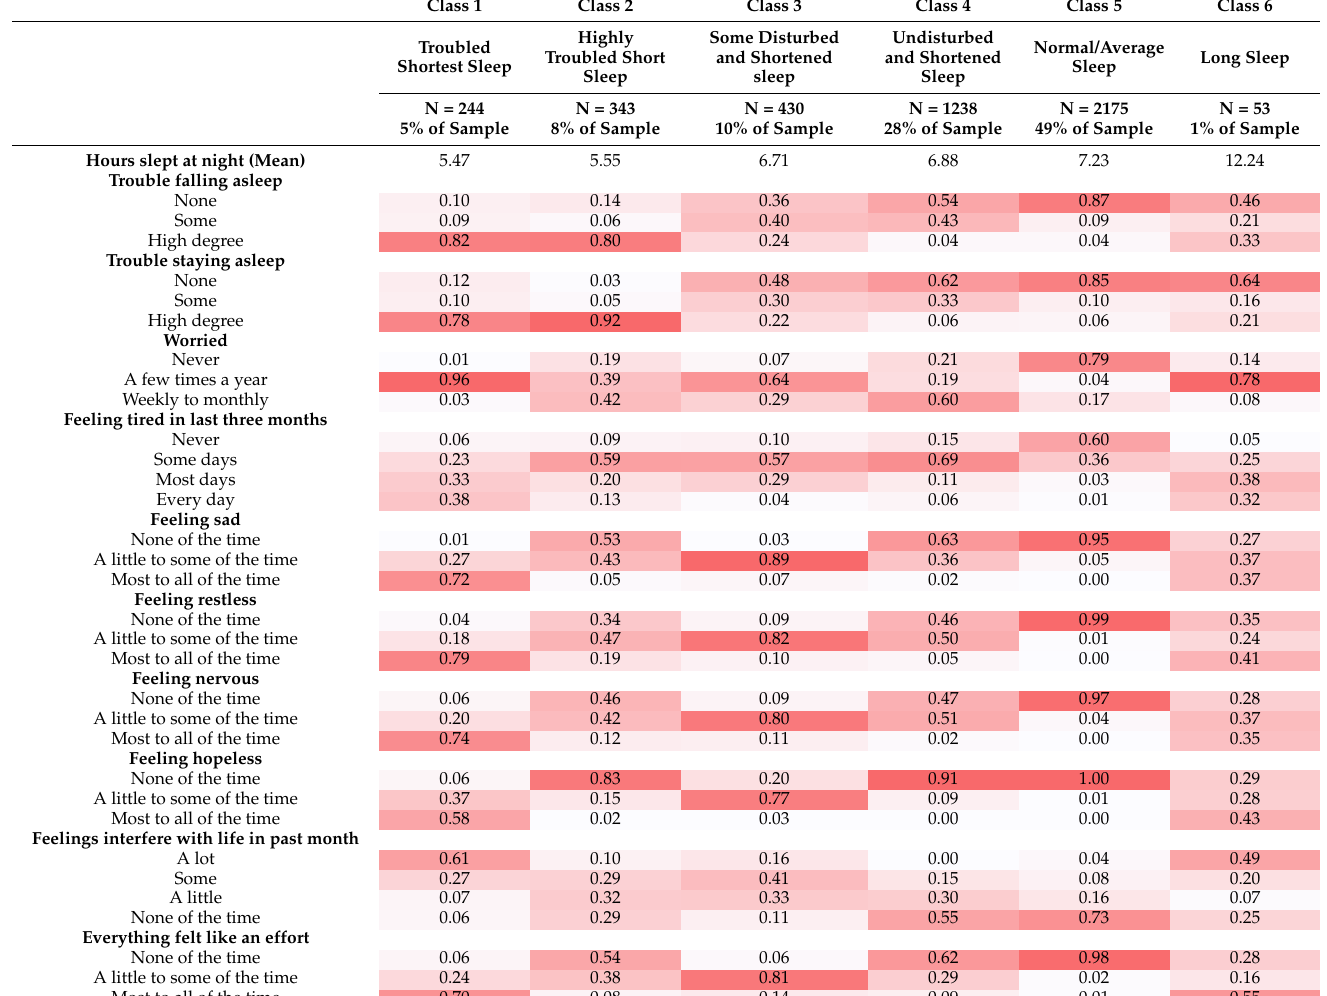
Table 3. Six-class solution conditional probabilities and mean (N =